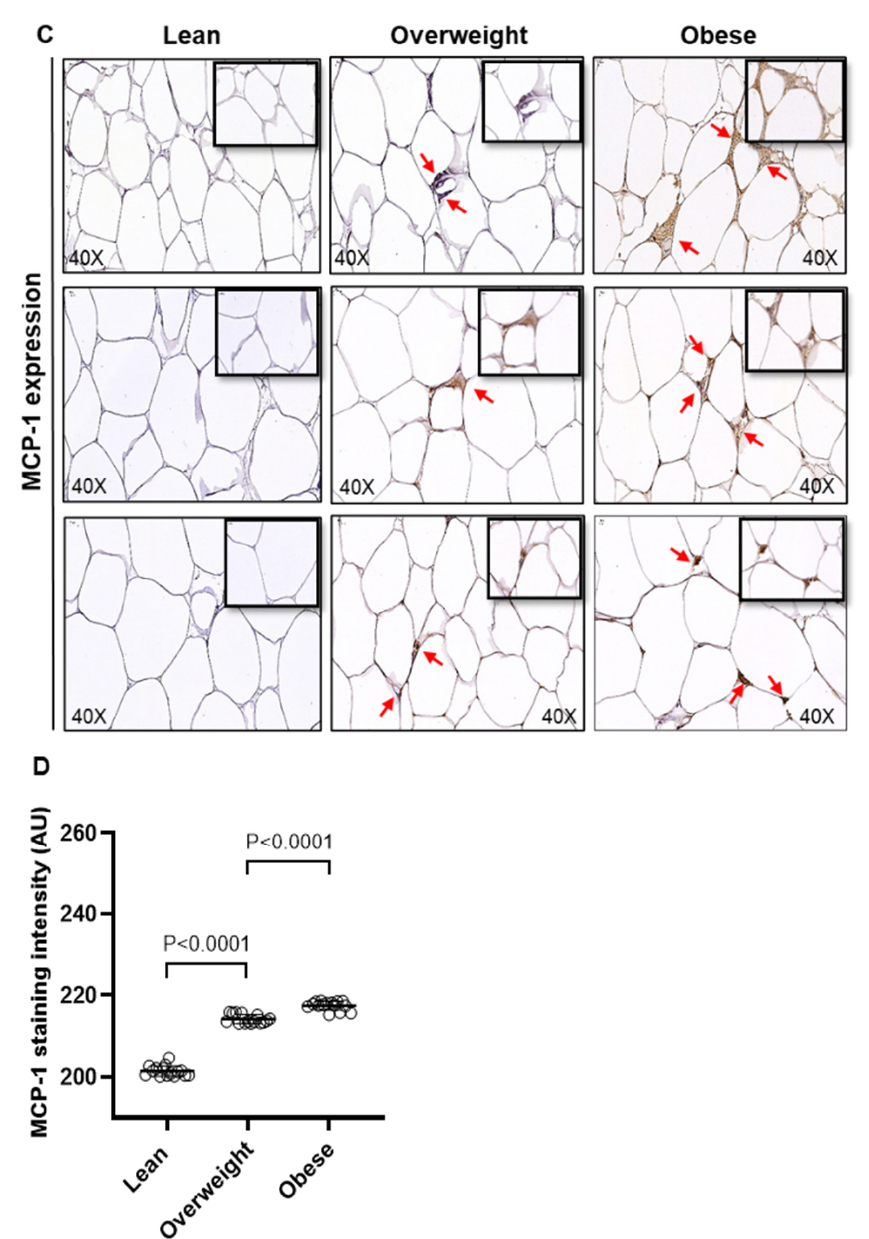
Figure 1. Adipose IL-8 and MCP-1 expression in lean, overweight, and obese individuals. IL-8 and MCP-1 protein expression was determined in adipose tissue samples from lean (BMI: 22.86 ± 1.89 kg/m 2 ), overweight (BMI: 27.80 ± 1.60 kg/m 2 ), and obese (BMI: 35.08 ± 3.73 kg/m 2 ), 15 individuals per group, using immunohistochemistry (IHC) as described in the materials and methods. One-way ANOVA (Tukey’s multiple comparisons test) was used to calculate group differences and p -values less than 0.05 were considered as